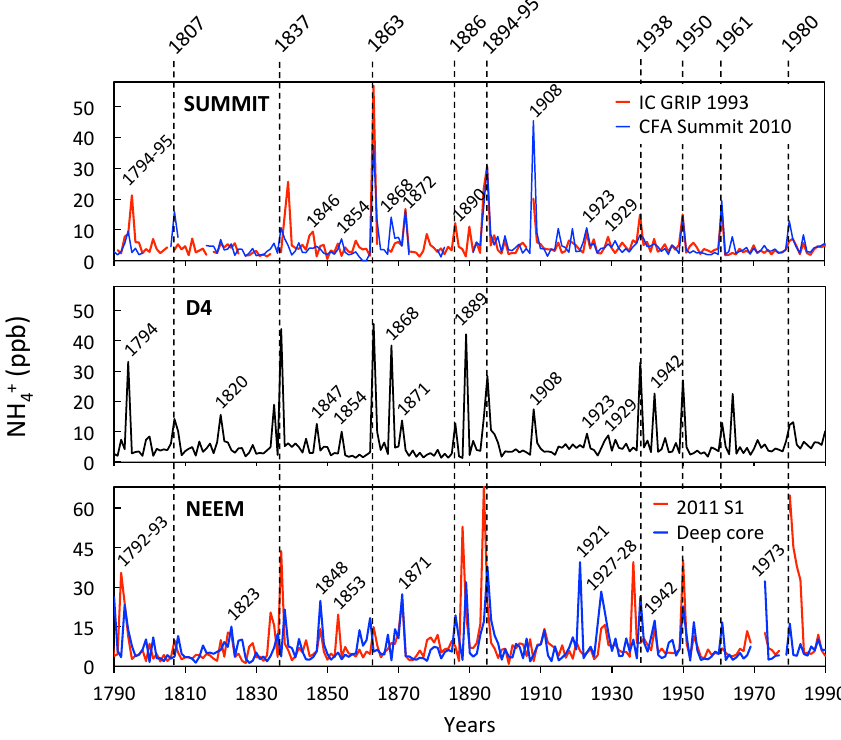
Figure 9. Comparison of several ammonium records obtained at Summit (IC for GRIP 1993, CFA for Summit-2010), D4 (CFA), and NEEM (CFA). All records are seasonally resolved, but data are presented here as annual means. Dashed lines denote the years for which a peak is identified at all sites. The IC GRIP 93 ammonium data are from Legrand and De Angelis